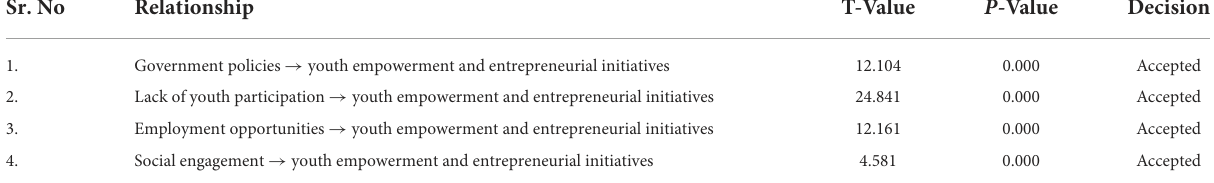
TABLE 3 Regression analysis